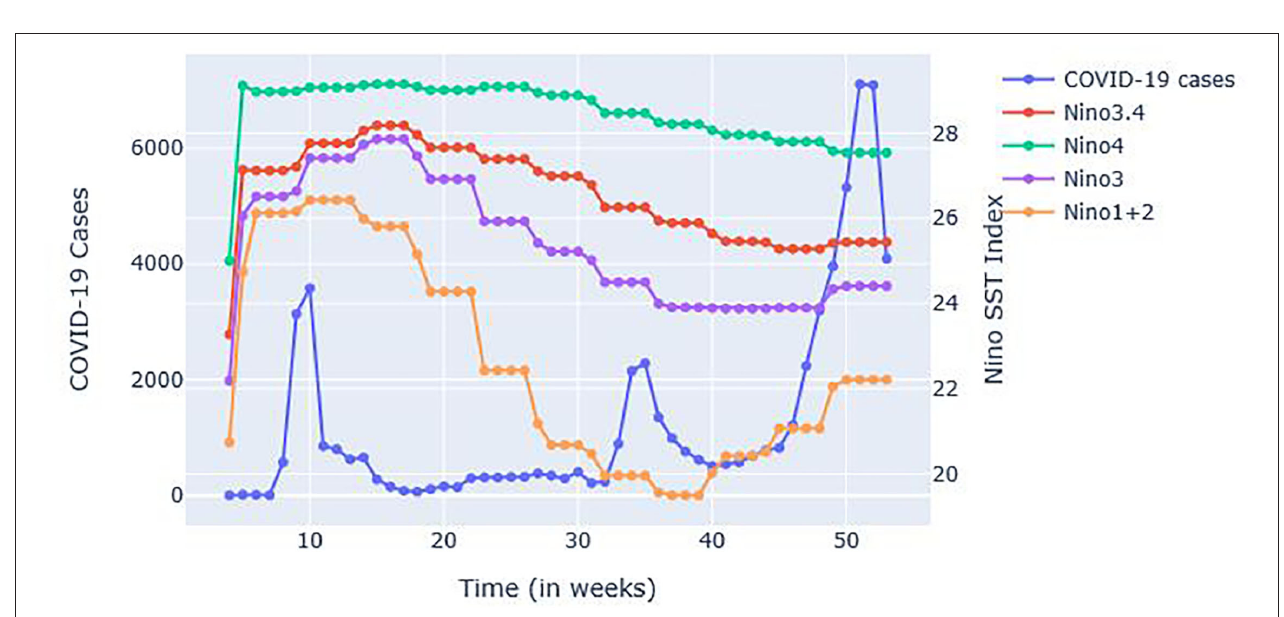
FIGURE 5 | Plot of Niño SST Indices and COVID-19 cases.